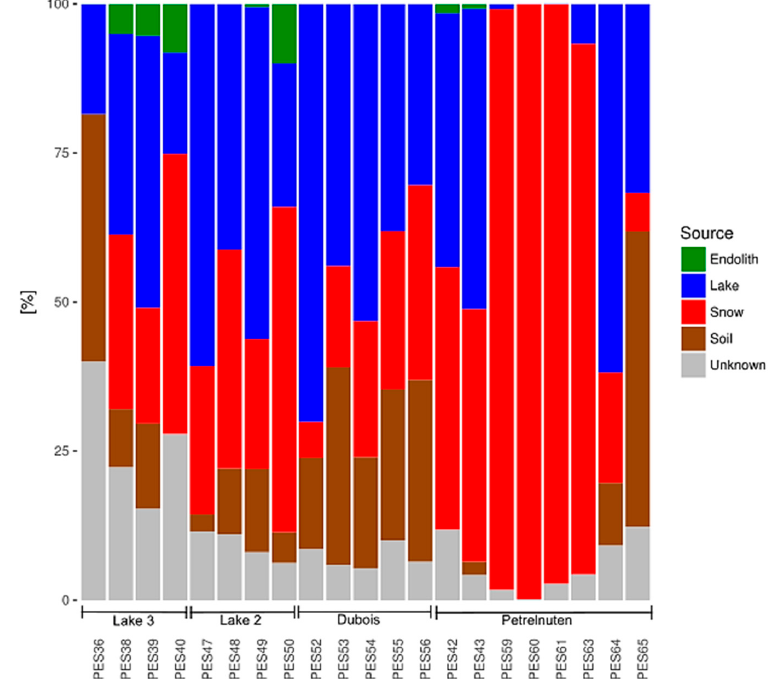
Figure 4. The relative contributions of the habitats endolith/rock, lake, snow and soil as potential sources for the composition of the bacterial community in the cryoconite hole samples, as well as the proportion from other (unknown) sources. Potential sources are more similar within the same sampling locations.